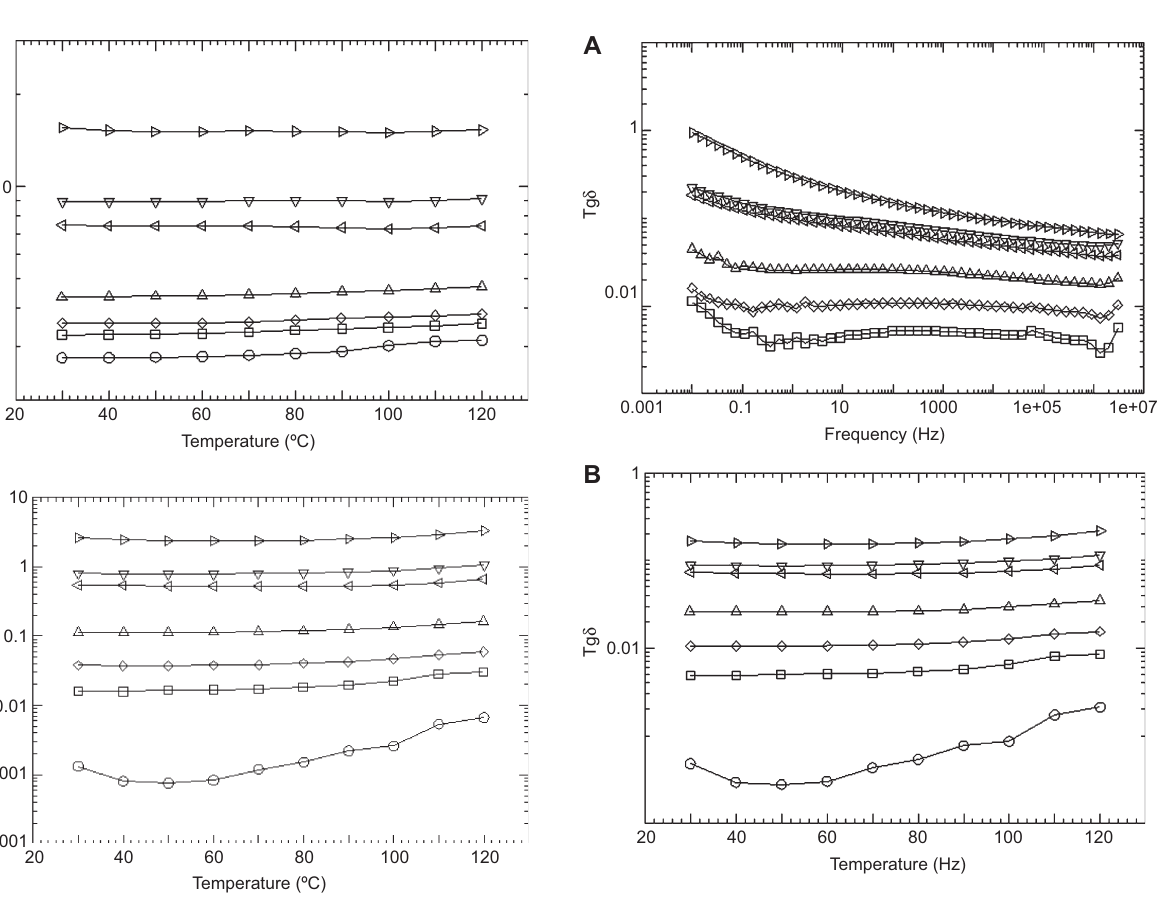
Figure 7 Real permittivity (A) and dielectric losses (B) of PS/GTR at 50 Hz in relation to temperature: ○ PS; □ PS+5% GTR; ◊ PS+10% GTR;  PS+20% GTR;  PS+40% GTR;  PS+50% GTR;  PS+70% GTR.